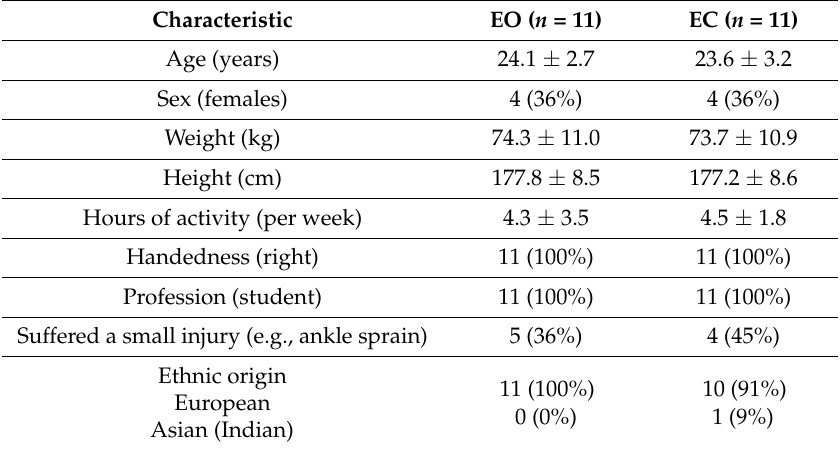
Table 1. Participant characteristics. EO: eyes-open group; EC: eyes-closed